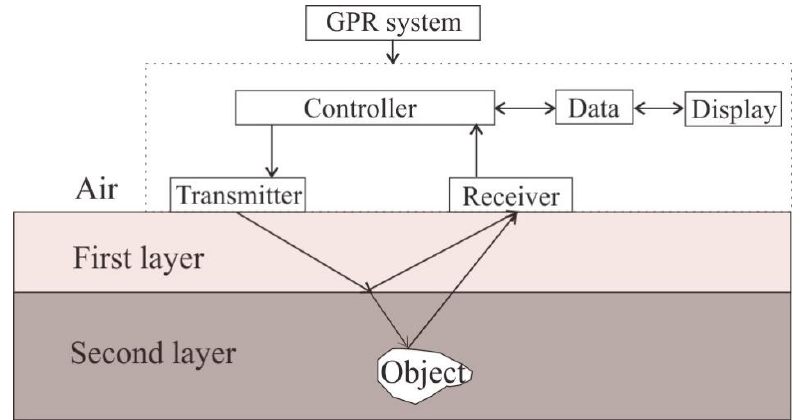
Figure 1. Ground penetrating radar (GPR) system and detection diagram.